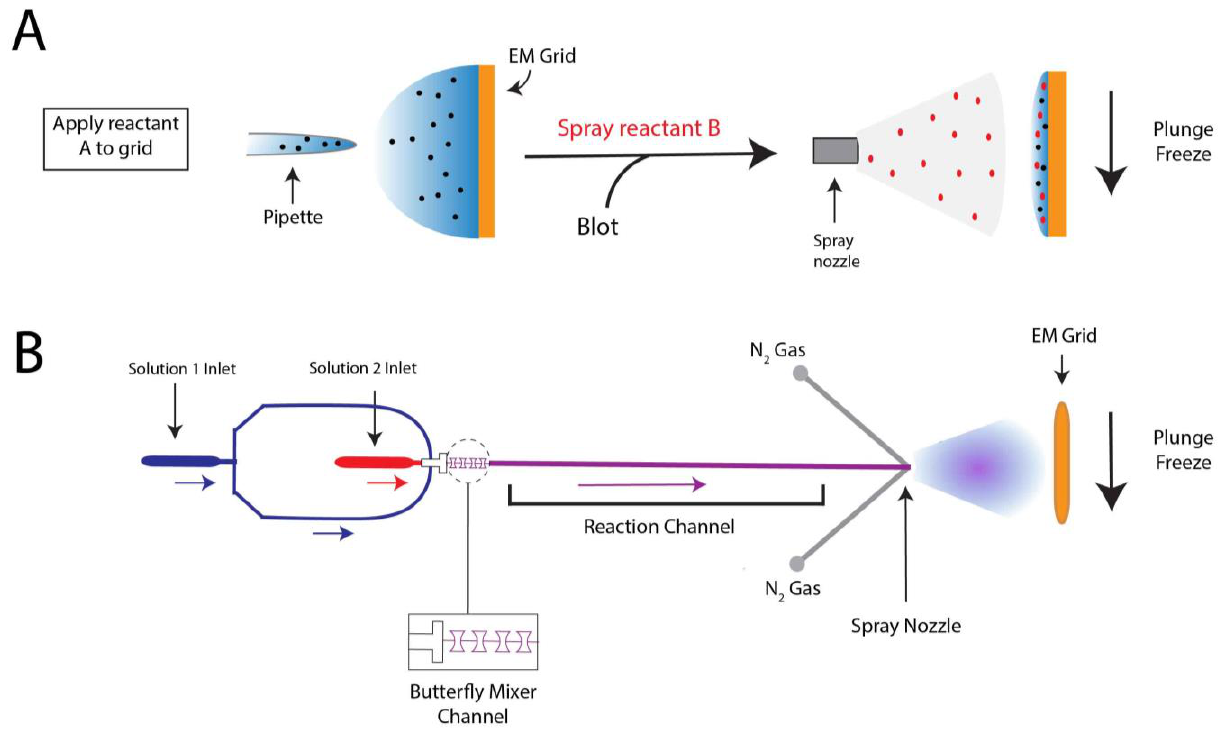
Figure 2. Sample mixing techniques for trEM. ( A ) Schematic of on-grid mixing, in which the first reactant is pipetted onto the cryo-EM grid, followed by blotting of the grid and spraying of the second reactant. The grid is then plunge-frozen. ( B ) In microfluidic mixing-spraying, the reactants (1 and 2) are injected into separate inlets of the microfluidic chip and mixed via a T-shaped mixer followed by four-tandem butterfly geometries [32]. The mixed reactants then traverse the reaction channel, whose length varies depending upon the desired reaction time. After meeting compressed nitrogen gas, the mixture is sprayed to a cryo-EM grid and plunge frozen. Colored arrows indicate the direction of the solution flow.